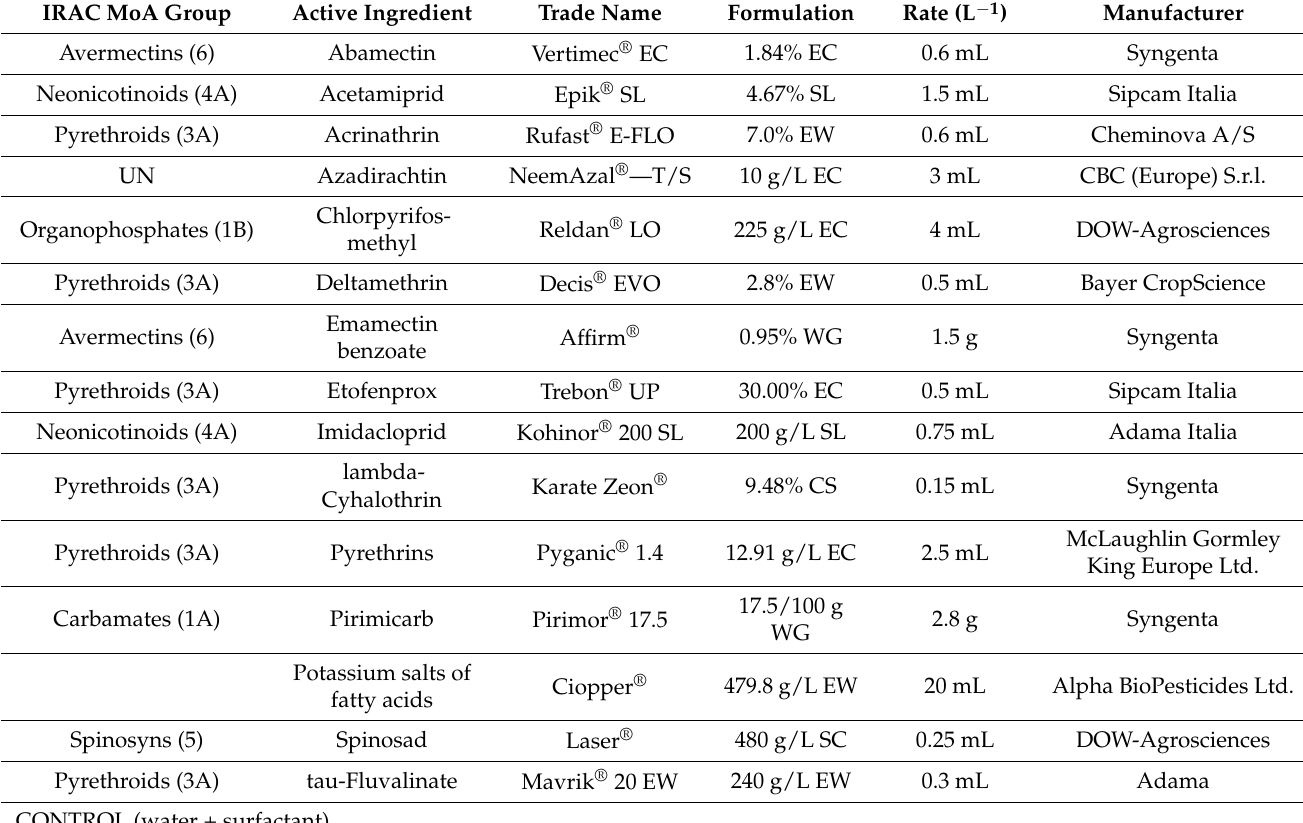
Table 1. Insecticides tested against SBW